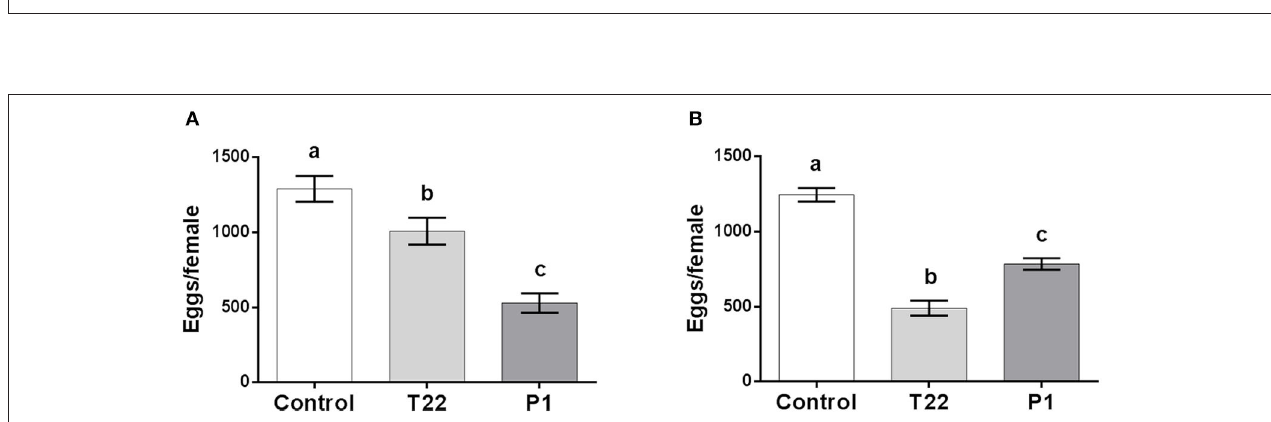
Frontiers in Plant Science |